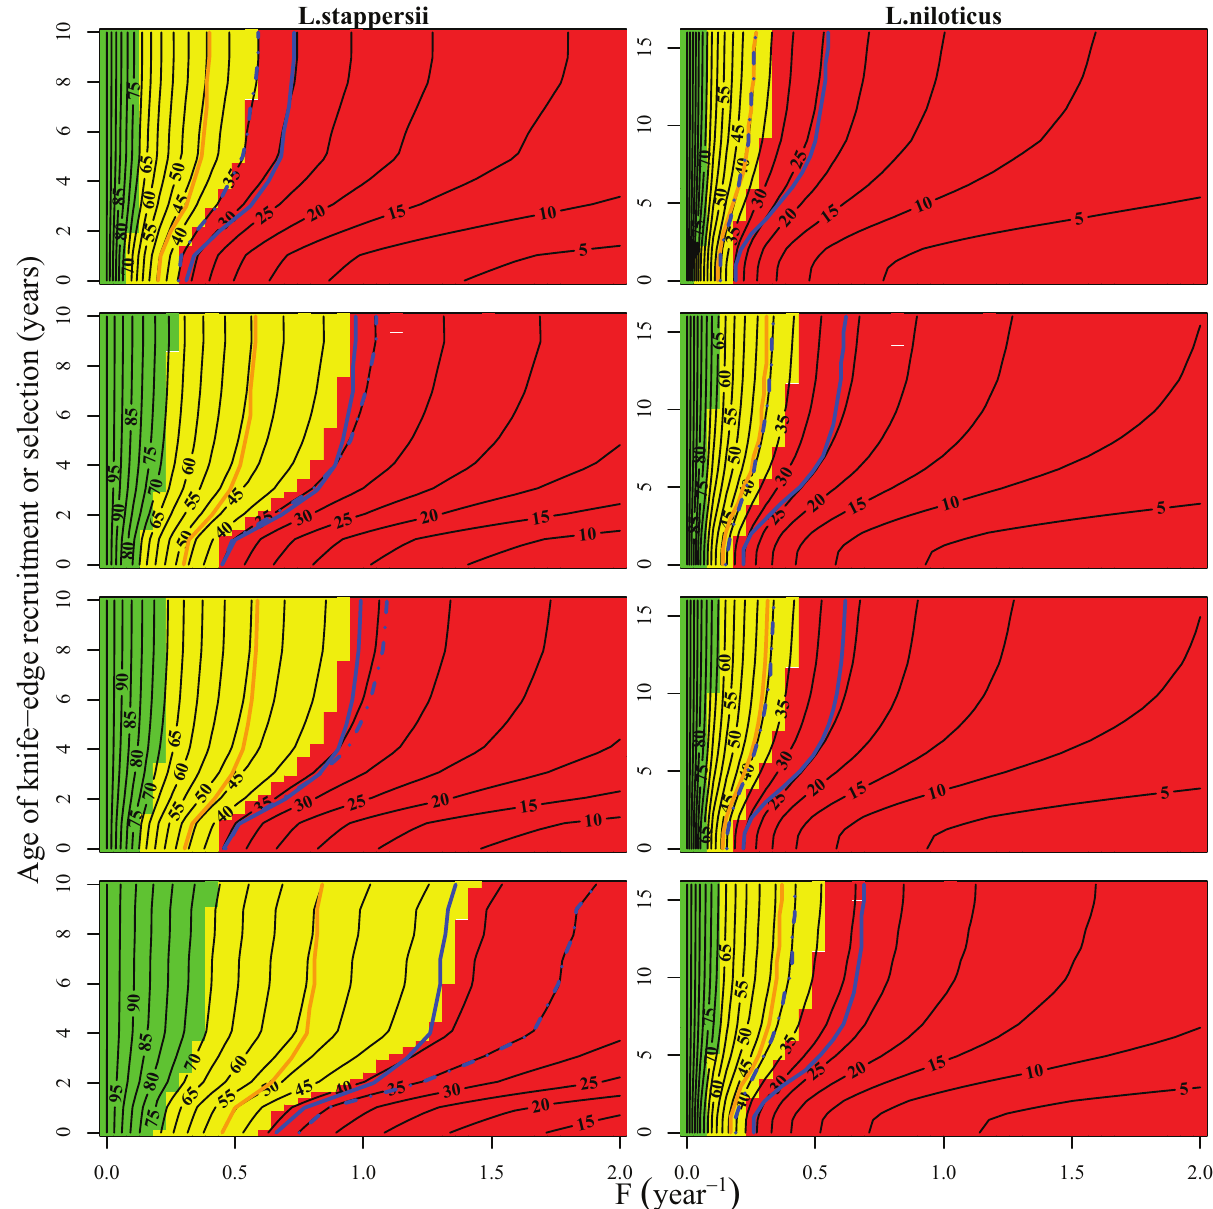
Fig. 3. Isopleths of, from top to bottom, the 2.5% percentile, median, mean, and 97.5% percentile of CSPR m.s. (%) as a function of fi shing mortality ( F ) and the age of knife-edge recruitment or the age of knife-edge selection for L. stappersii in Lake Tanganyika (left panels) and L. niloticus in Lake Victoria (right panels). The plots also show the variations of the 2.5% percentile, median, mean, and 97.5% percentile of F CYPR (blue solid line), F 0.1 (orange solid line), as well as F 35%CSPR for L. stappersii and F 40%CSPR for L. niloticus (blue dash-dotted line) against the age of knife-edge recruitment. Areas shaded by the red color, yellow color, and green color are, respectively, topographies of low CSPR, intermediate CSPR, and high CSPR. If F CYPR , F 0.1 , or F at a target CSPR is treated as the fi shing mortality target, the region below and to the right of the corresponding lines represents recruitment-over fi